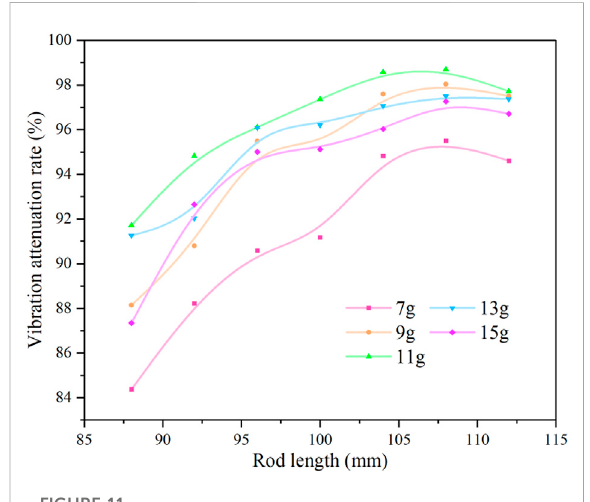
FIGURE 11 Vibration attenuation rate versus rod length with different magnetic fl uid mass.